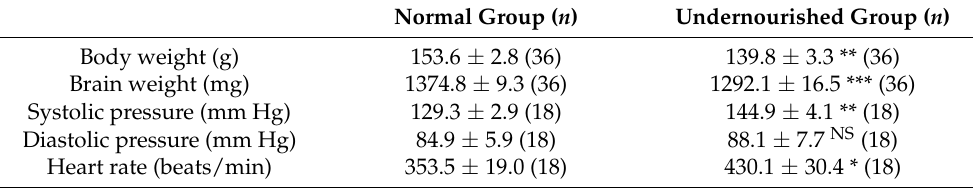
Table 1. Body weight, brain weight, systolic pressure, diastolic pressure, and heart rate of normal and malnourished rats at 40 days of age.